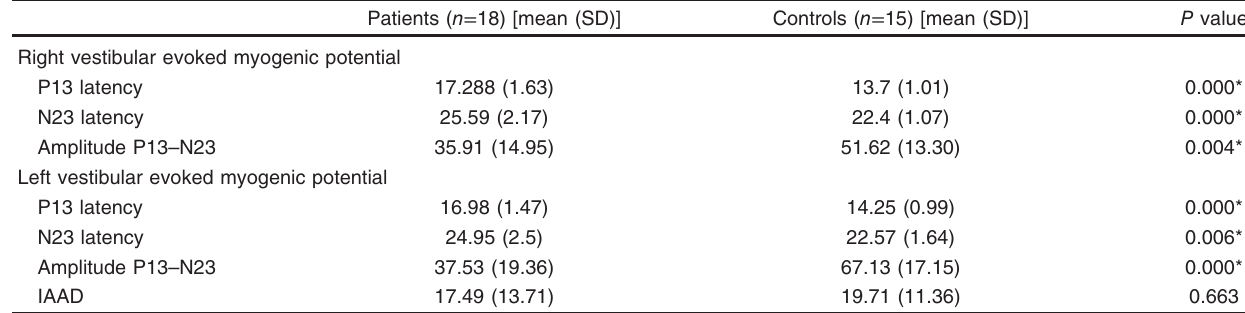
Table 3 Cervical vestibular evoked myogenic potential results in Parkinson disease group and control